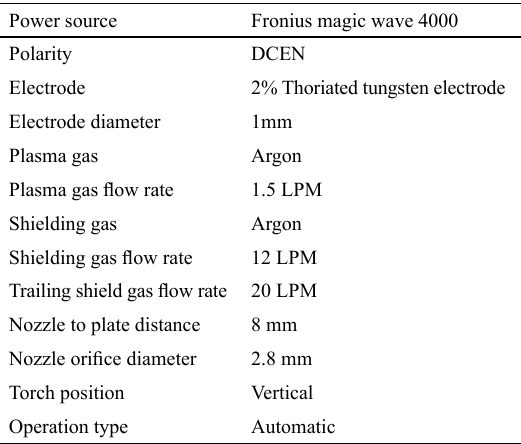
Table 2. PAW experimental set up conditions.